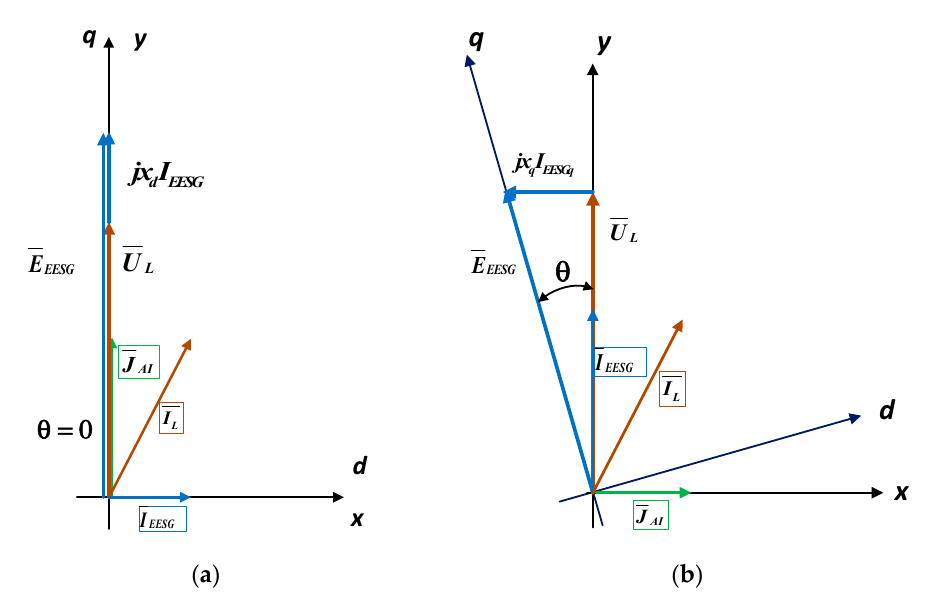
Figure 9. ( a ) Vector diagram for the case of taking the whole load of active power by SGAR + AI and all reactive power by EESG. ( b ) Vector diagram for the case of taking the whole load of active power through the EESG and all reactive power through SGAR + AI.